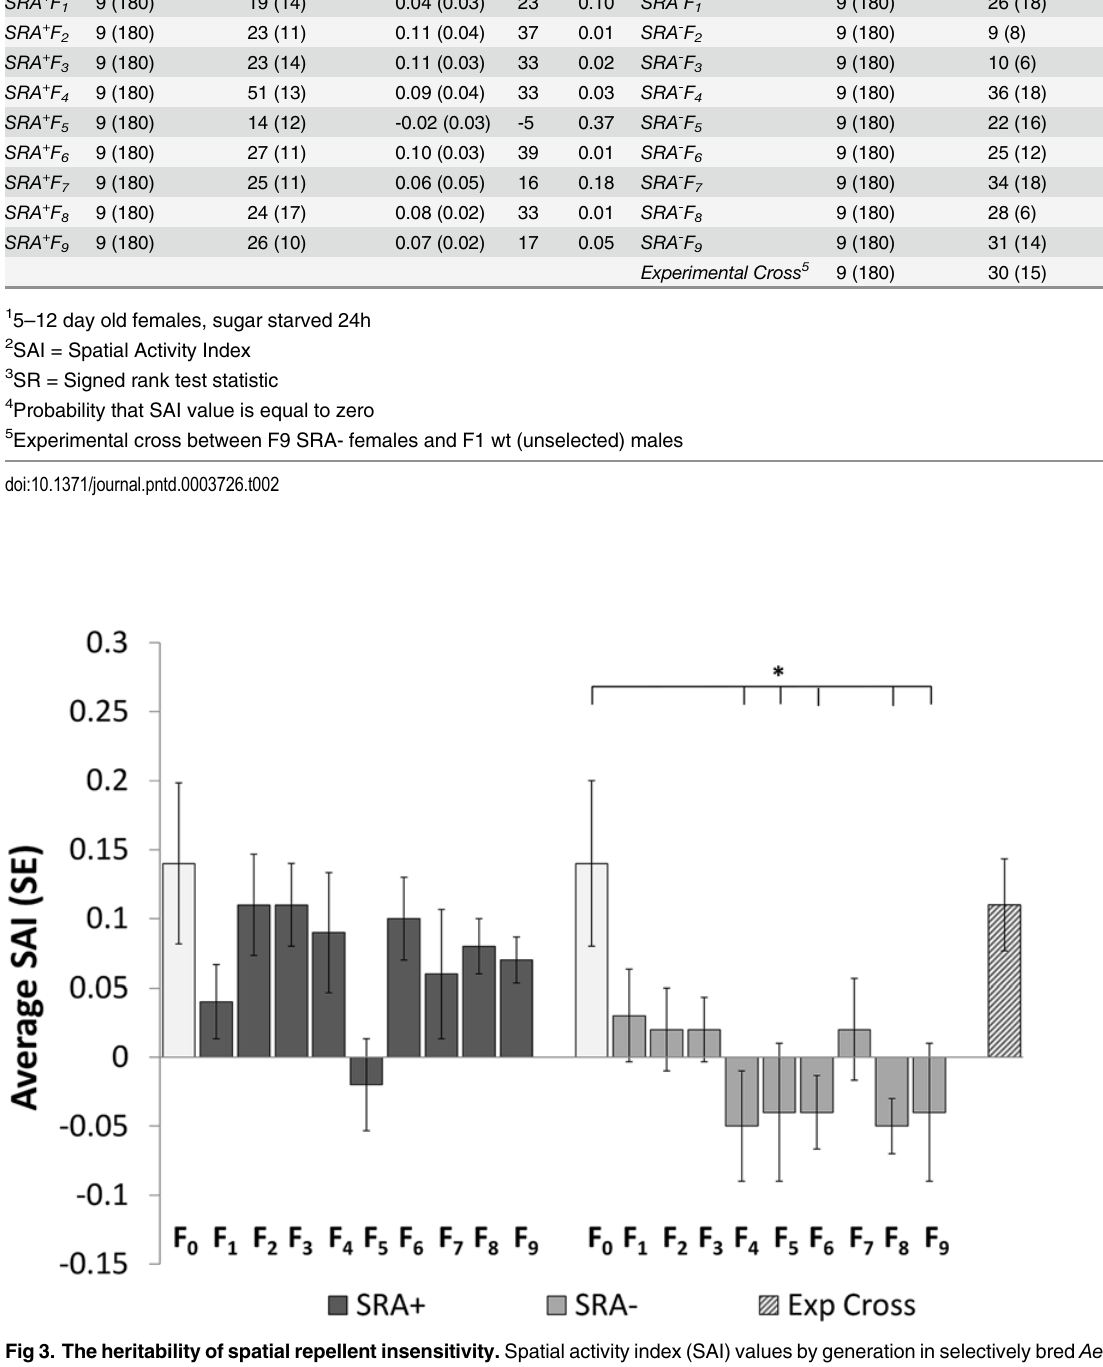
Table 2. Spatial repellency behaviors in selectively bred Aedes aegypti 1 responders (SRA+) and non-responders (SRA-). Number Trials (No. Mosqu.)